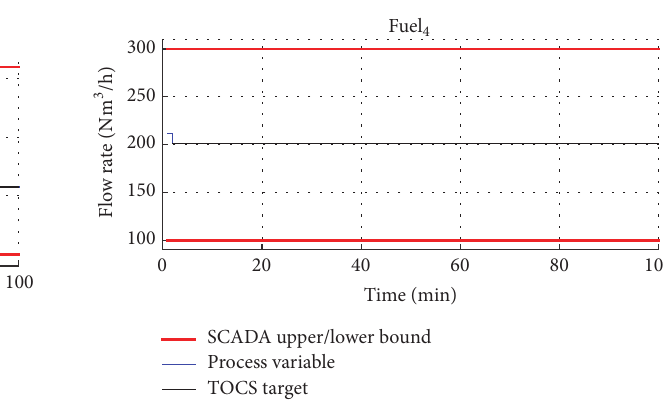
Figure 10: Zone 5 stoic. ratio trends.